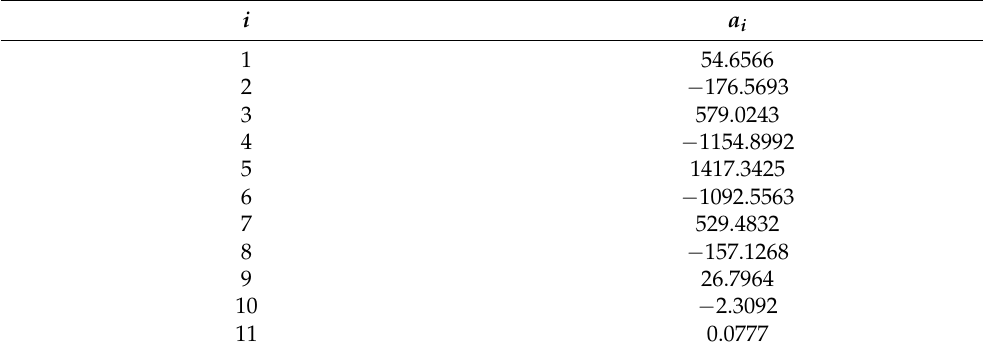
Table 1. Function H ( B ) coefficients obtained from solving the estimation problem based on the manufacturer’s